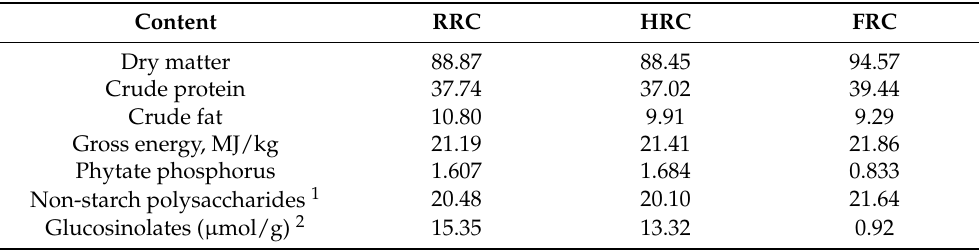
Table 2. Nutrient composition of rapeseed products and the presence of antinutritional factors (%, dry matter basis).